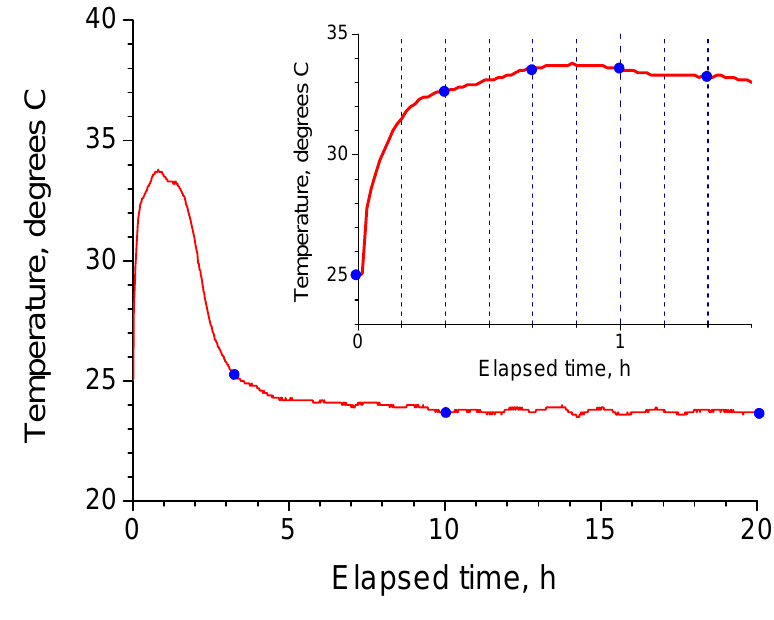
Figure 12. Temperature profile in the epoxy resin cure process. The upper right figure is the enlarged temperature profile until 90 minutes after pouring the resin. The blue circles indicate the times at which the transmission spectra were